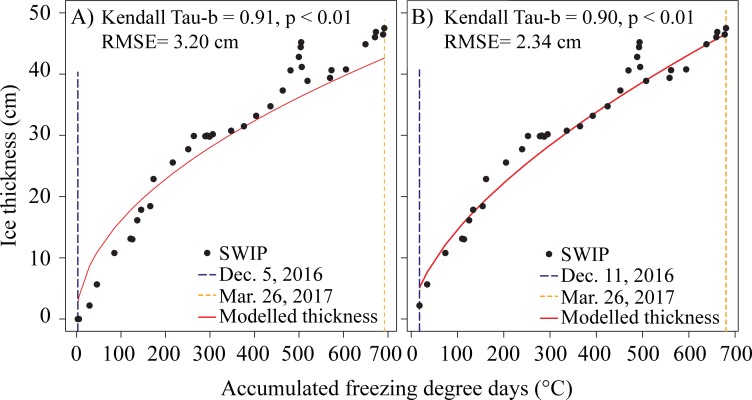
Comparison of the initial and optimized AFDD model.The initial model (A) (optimized βF of 1.73 and constant γ of 0.5) on the validation dataset for the 2016–2017 ice season, the dark blue solid line is December 5th, the date of initial thickening, and the orange solid line is March 26th, the date of maximum ice thickness. The optimized AFDD model (B) (optimized βF of 0.94 and optimized γ of 0.60) on the validation dataset for the 2016–2017 ice season. Ice thickening begins December 11th, 2016 (blue line) and maximum ice thickness is reached on March 26th, 2017 (orange line). The solid circles represent the daily average ice thickness from the SWIP.